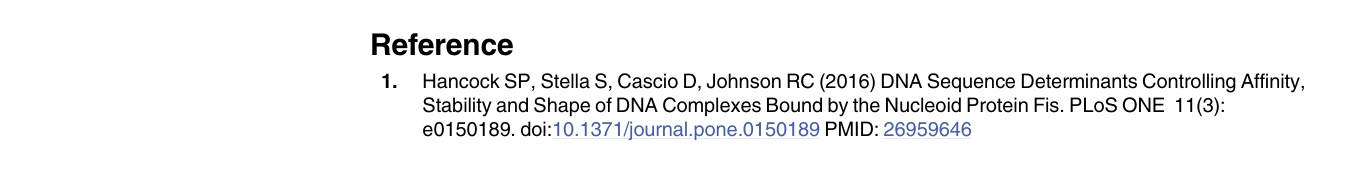
1 Inter- fl uorophore distance calculated from FRET ef fi ciency as detailed in the Methods. 2 Angle calculated assuming a single central bend in the Fis-bound DNA as detailed in the Methods.